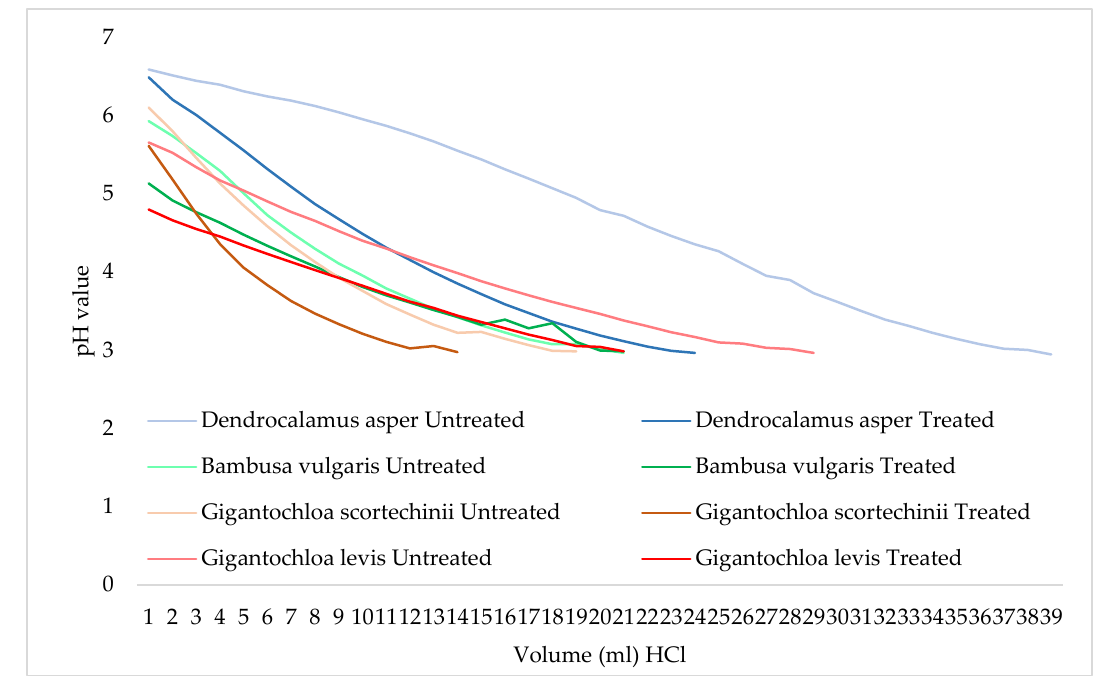
Figure 8. Stability of untreated and treated bamboo strips of four selected species in acidic conditions. Table 7. Mean values for the mechanical properties of untreated and treated bamboo strips from different